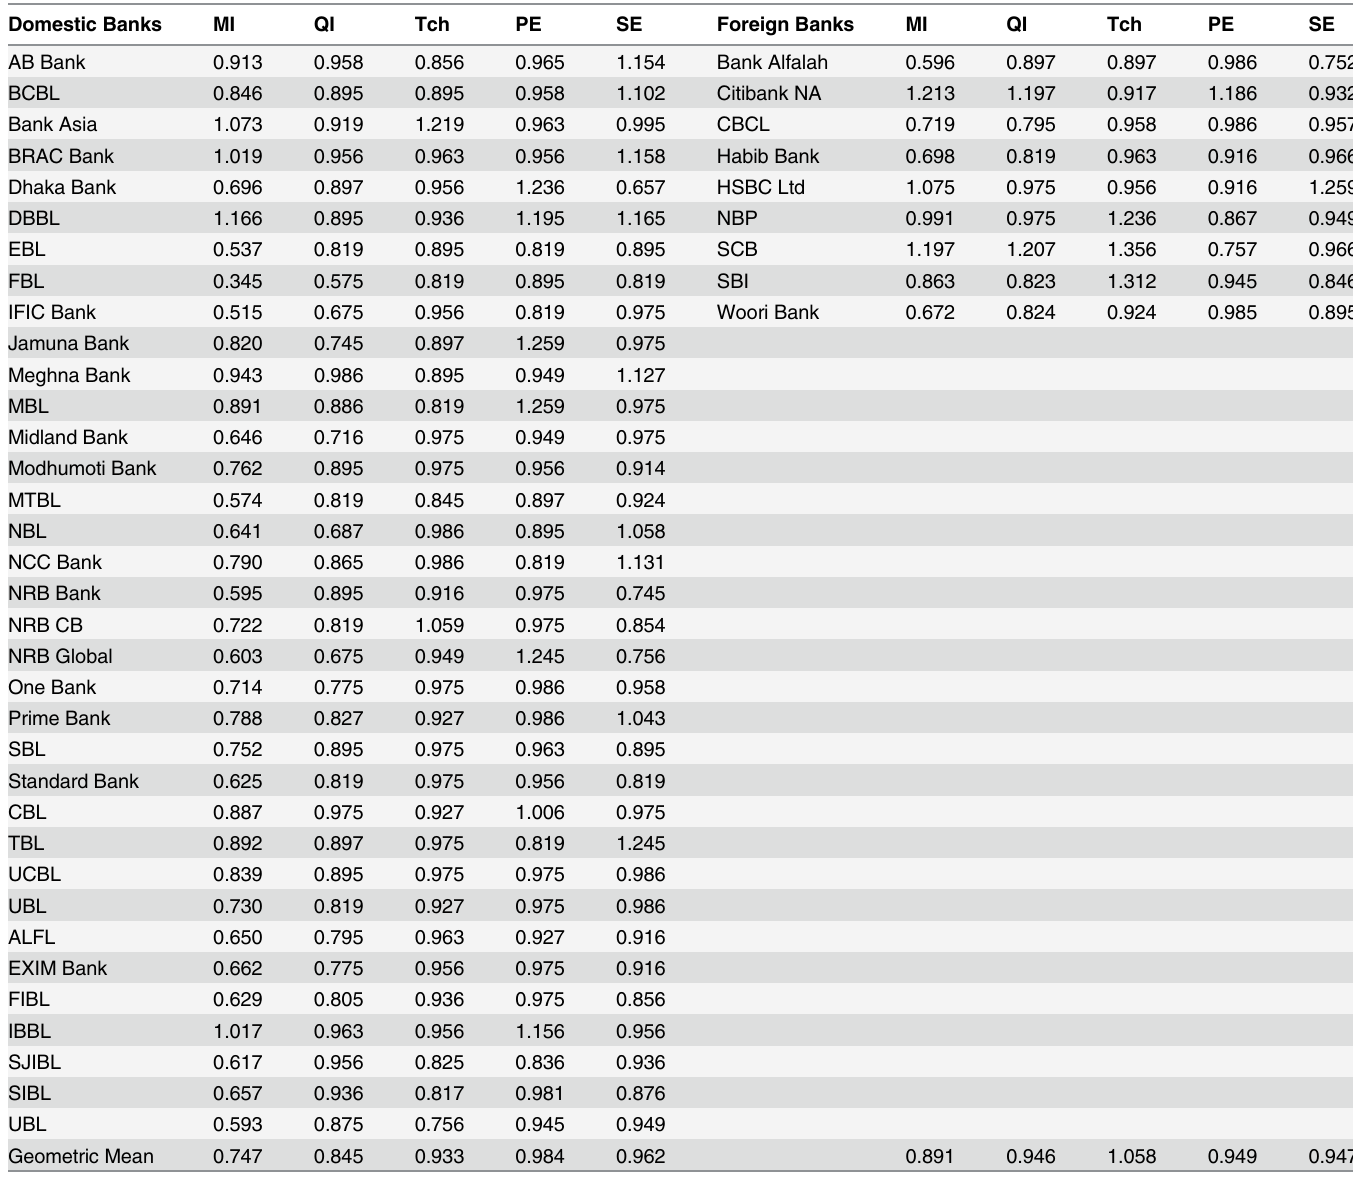
Table 5. Summary results of Malmquist index (MI) and its